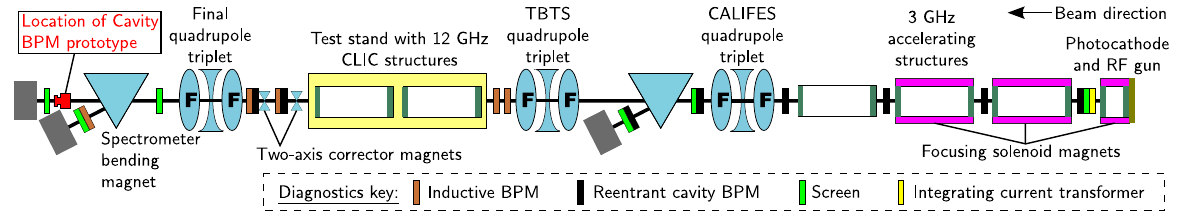
FIG. 4. Diagram of the CALIFES beam line showing the location of all major diagnostics, the prototype cavity BPM installation and the two dipole corrector magnets that were used to measure the position sensitivity of the